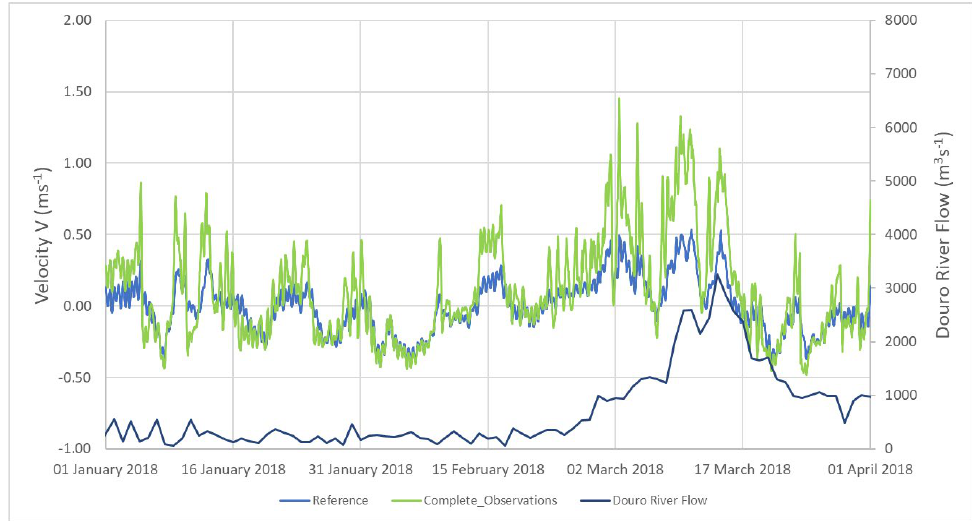
Figure 9. Surface modelled meridional velocity at the A Guarda station for the PCOMS reference scenario (no river discharge) and the Complete Observations scenario boundary conditions for the first quarter of 2018. Douro River observed flow (source: Portuguese Environmental Agency − APA) is represented in the right axis.